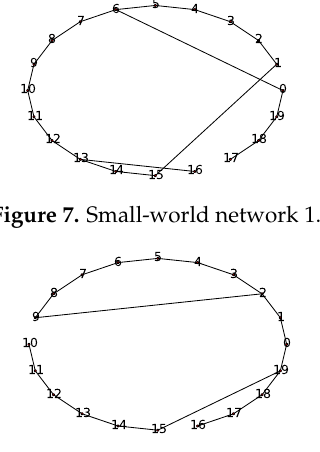
Figure 8. Small-world network